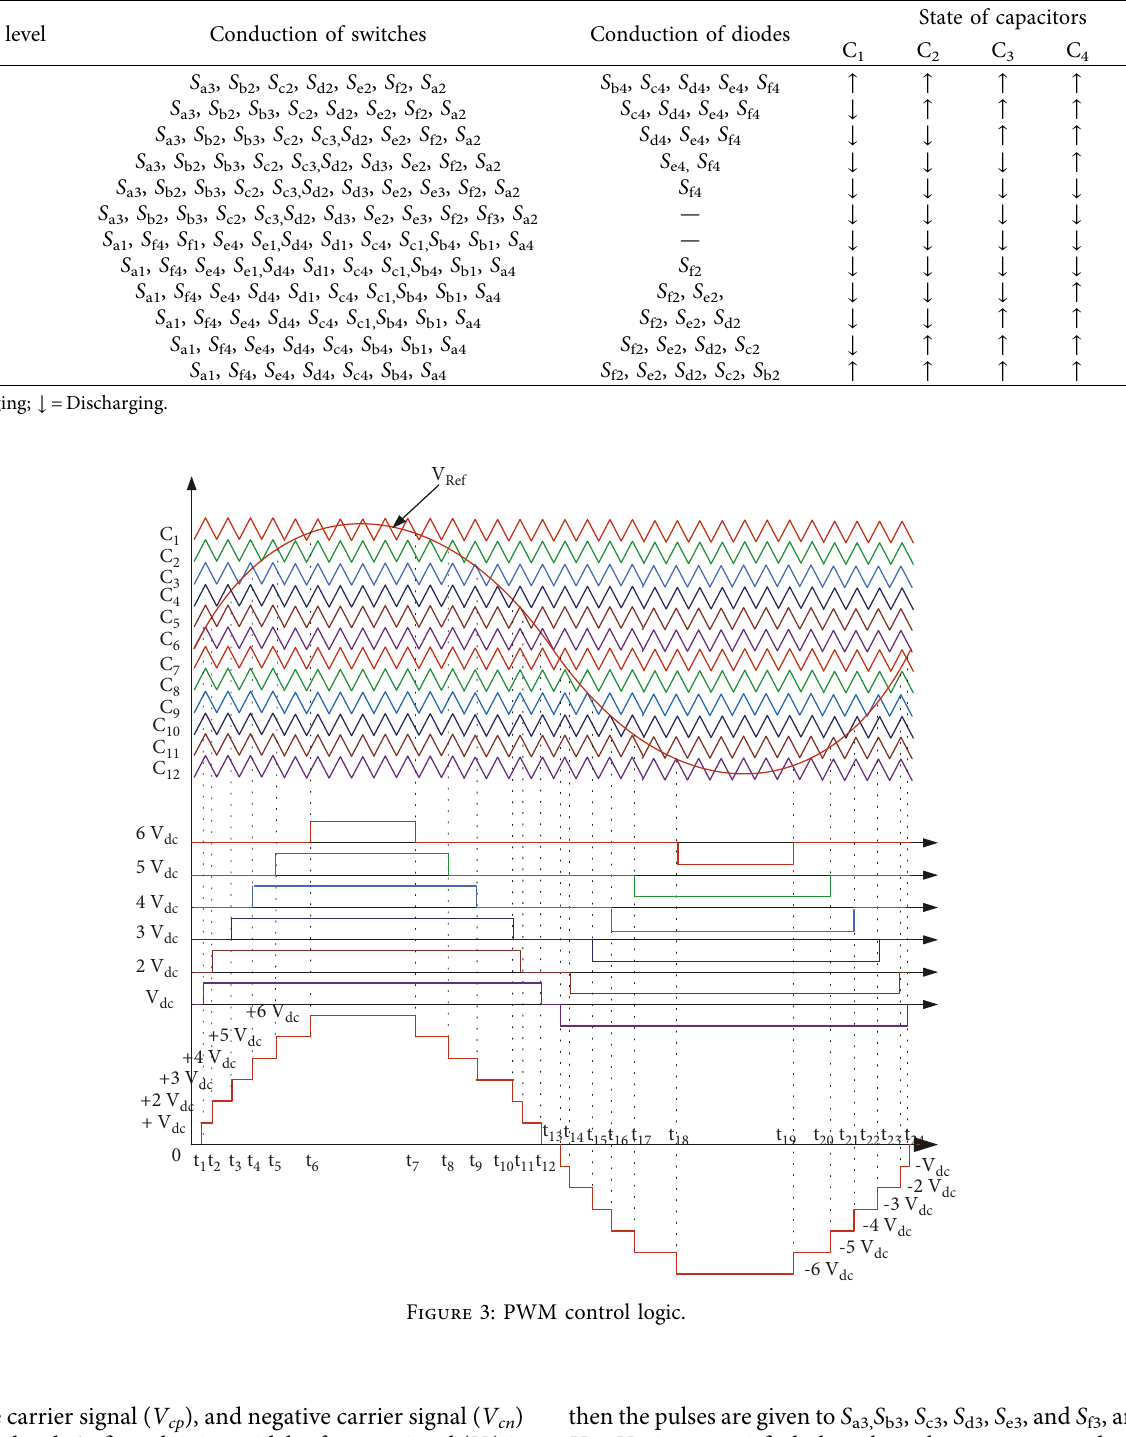
Table 1: Modes of operation and state of